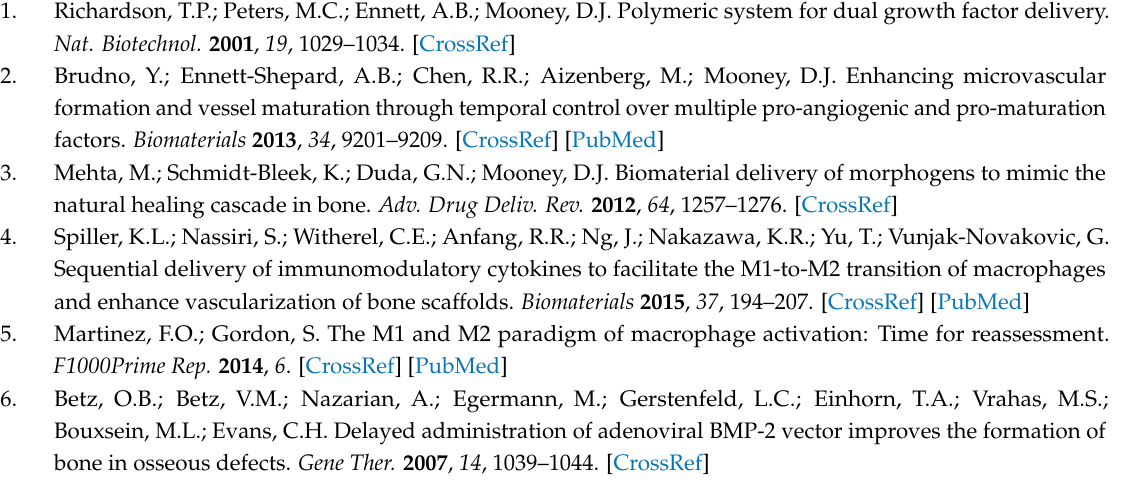
Supplementary Materials: The following are available online, Descriptions of melanoma cell survival study methodologies and results (Figure S1) are included in supplementary